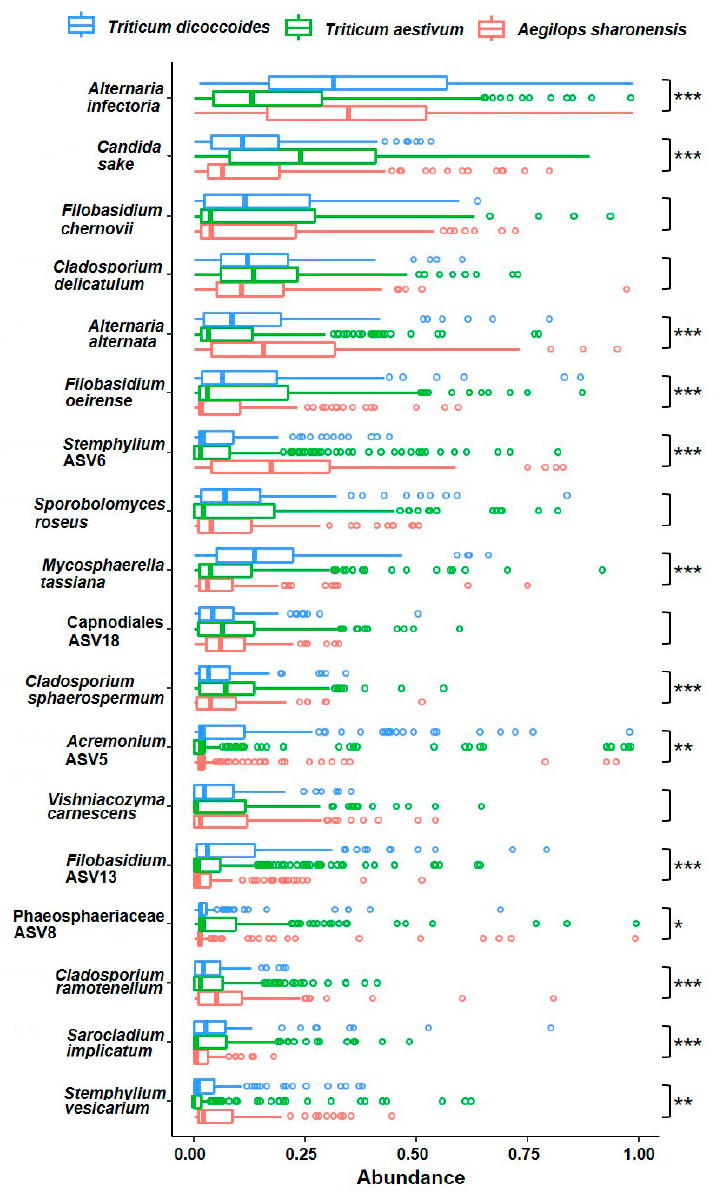
Figure 4. Abundance of the most dominant fungal taxa in each of the three plant species. The top 18 most abundant endophytic taxa accounted for 50% of total abundance in the core dataset. The Hellinger transformed abundance of each taxon is shown for each of the three host plants. Outliers are plotted with open cycles. One-way ANOVA was used to test the significance of abundance difference among hosts ( p < 0.001, ***; p < 0.01, **; p < 0.05, *).